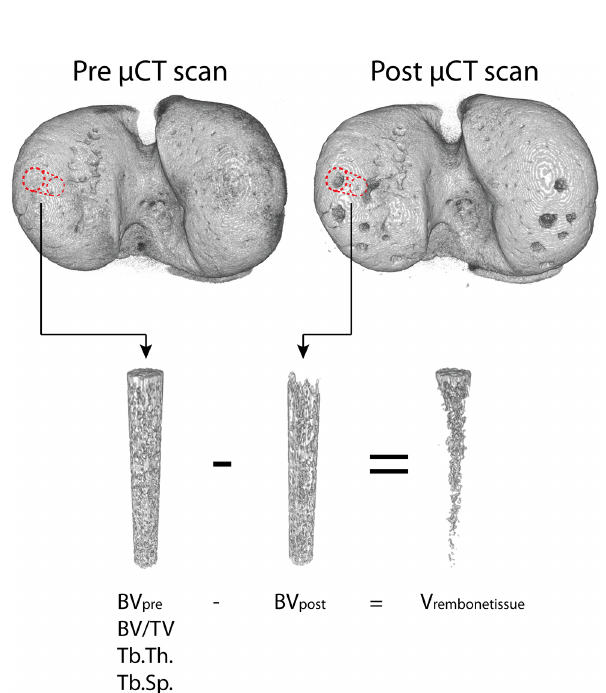
Figure 2. Method of measuring the bone structural properties and bone volumes.